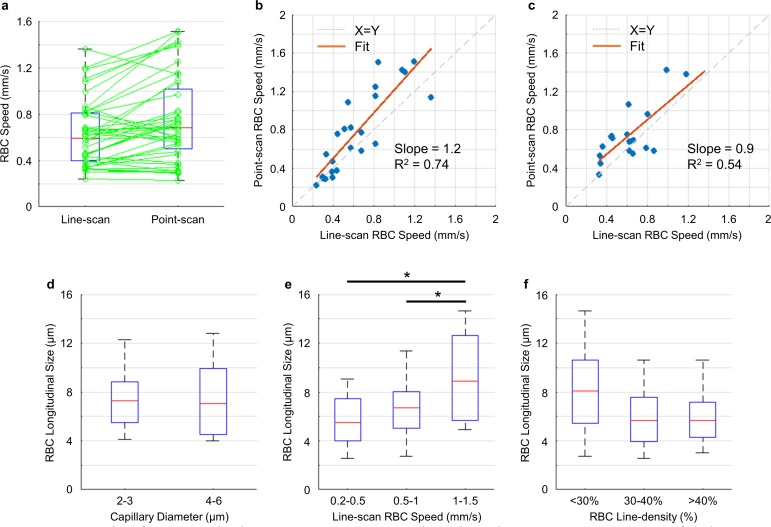
Comparison between the capillary RBC speed measurements by the line-scan and point-scan methods.Estimation of the RBC speed based on the measured RBC-passage time through the excitation focal volume (i.e. ‘RBC-passage’ or ‘point-scan’ method) requires a knowledge of the RBC longitudinal size. In this work, we assumed a constant RBC longitudinal size (6 µm) (Unekawa et al., 2010) when estimating the RBC speed (please see Materials and methods section for details). However, the RBC longitudinal size may vary with capillary diameter, RBC speed and hematocrit (Chaigneau et al., 2003). To better understand this limitation, we performed line-scan measurements in 58 capillaries in two awake C57BL/6 mice (3–5 months old, female, 20–25 g, Charles River Laboratories). The cranial window was prepared following the same protocol as described in the Materials and methods section. The blood plasma was labeled by dextran-conjugated Sulforhodamine-B (0.1 ml at 5% W/V in saline, Sigma R9379). The line-scans (2-s-long acquisition in each capillary with 2 kHz line-scan rate) were performed within the cortical depth of 0–200 µm. The RBC speed was calculated from the line-scan images with the procedures described in Kleinfeld et al. (1998). In addition, we extracted the fluorescence intensity time courses from the same parallel line-scan images, and then the RBC speed was calculated by using the procedures described in the Methods section (i.e. by the ‘point-scan’ or ‘RBC-passage’ method). Furthermore, we investigated the dependence of RBC longitudinal size on capillary diameter, RBC speed, and linear-density. (a) The capillary RBC speed values estimated simultaneously by both the line-scan and point-scan methods. The RBC speed values obtained by the two methods in each capillary (green circles) are connected by green lines. Boxplots of the line-scan and point-scan RBC-speed values indicate the median values, the 1st and 3rd quartiles, and the maximum and minimum values. (b) and (c) Correlation between the line-scan and point-scan RBC speed values from the same n = 58 capillaries used in a), grouped by the capillary diameter: 2–3 µm (b) and 3–5 µm (c). In panels b and c, we also presented the corresponding linear regression lines (orange), as well as their slopes and coefficients of determination (R2). (d-f) Dependence of the RBC longitudinal size on capillary diameter (d), RBC speed (e), and line-density (f). For each of the 58 capillaries, we estimated the capillary diameter by fitting the transversal intensity profile to a Gaussian model. The diameters were calculated as the full width at half maximum of the Gaussian profiles. The RBC line-density and longitudinal size were calculated by following the procedures described in Chaigneau et al. (2003). By averaging over all the RBCs identified in each capillary and then across the 58 capillaries, we obtained the mean RBC longitudinal size (6.9 ± 3.0 µm; Mean ±STD). The mean RBC longitudinal size in the capillaries with smaller diameter (2–3 µm; panel d) was just slightly (statistically not significantly) larger than in the capillaries with larger diameter (4–6 µm). This result can be expected as the RBCs in the smaller capillaries may be squeezed to a greater extent. We further observed that the RBC longitudinal size increased with RBC speed (e), where the RBC longitudinal size in the fastest group of capillaries (1–1.5 mm/s) was statistically significantly larger than in the other two lower speed groups. Finally, the capillaries with lower-line-density had more elongated RBC size than the capillaries with median- and higher-line-density (f), although the difference was not statistically significant. The statistical comparison in d) was conducted using Student’s t-test. The statistical comparisons in e) and f) were conducted using ANOVA followed by a Tukey-HSD post-hoc test. The asterisk symbol indicates p<0.05. Data from 58 capillaries were used for the analysis in a and (d-f) and data from 25 and 19 capillaries were used for the analysis in b and c, respectively. In addition, we analyzed the temporal fluctuation of the RBC longitudinal size during the 2-s-long acquisition. For each capillary, we computed the standard deviation (STD) and coefficient of variance (CV) of the RBC longitudinal size from the individual RBC measurements acquired during the 2-s-long acquisition. Then, we obtained the mean STD (2.3 ± 0.6 µm) and CV (0.4 ± 0.1) values averaging over the 58 capillaries. Based on presented results, RBC longitudinal size may be different from capillary to capillary as a function of capillary diameter, RBC speed, and line-density, and may vary over time within the same capillaries. The RBC longitudinal size was especially large at high RBC speed (e). In addition, the average temporal fluctuation of the RBC longitudinal size was moderate (STD = 2.3 ± 0.6 µm). Finally, pairwise comparisons between the RBC speed values obtained by the two methods (a–c) reveal variability, especially at the high RBC speed. Therefore, instantaneous RBC speed obtained by the point-scan method may have larger measurement error, which needs to be considered when interpreting the data. On the other hand, the small difference between the mean RBC speed obtained in the paired measurements (a) did not reach statistical significance (Student’s t-test), and the linear regression slopes in panels b and c are reasonably close to 1. Therefore, for the purpose of providing mean values for group comparison, the RBC speed measurements based on the point-scan method, while limited by assuming the constant RBC longitudinal length, may still be reasonably accurate. Please note that regarding the extreme values of the estimated RBC longitudinal size (d–f), they were calculated as the product of the fitted temporal width of the shadows and the RBC speed, both of which were extracted from the line-scan images. Measurements of both these parameters have limitations. The line-scan method is less accurate for high RBC speed, while estimation of the shadow width sometimes may be influenced by the stacked RBCs, and the fluorescence intensity time courses may be noisier when acquired with the line-scan method (due to shorter dwelling time per time-point) than with the point-scan method.